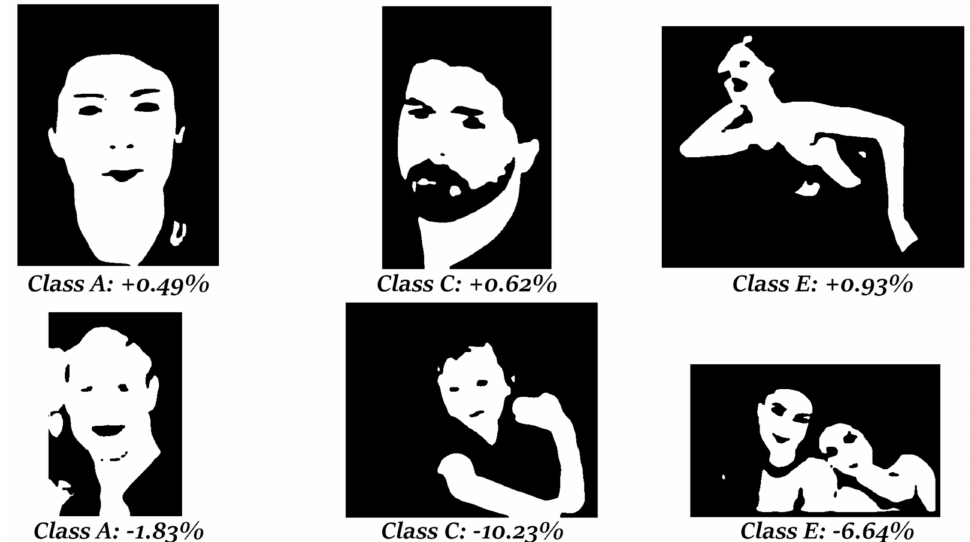
Figure 3. First row: images from the classes (A, C, and E) in which the homogeneity method obtained better results and the relative increment over the F1-measure. Second row: pictures from the same classes in which the homogeneity algorithm gave poor results with respect to the morphological